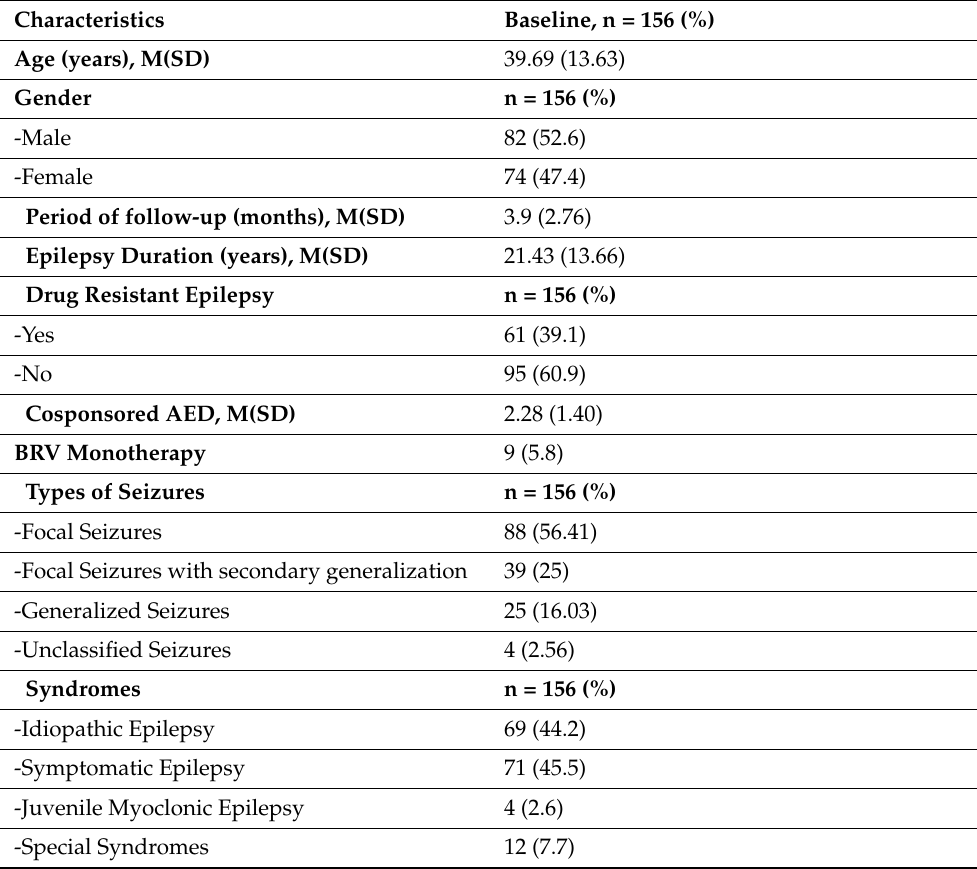
Table 1. Patients’ Characteristics. (M: median, SD: standard deviation).